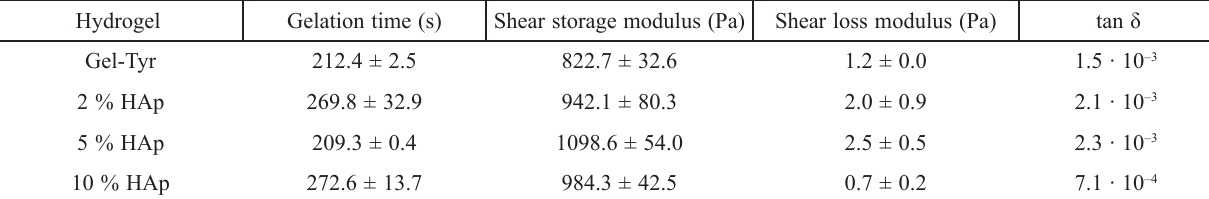
Table 1 – Gelation time, storage, and loss modulus of different hydrogels evaluated at an angular frequency of 1.26 rad s –1 using 1 % of strain at 25 °C. The values represent the average of three individual